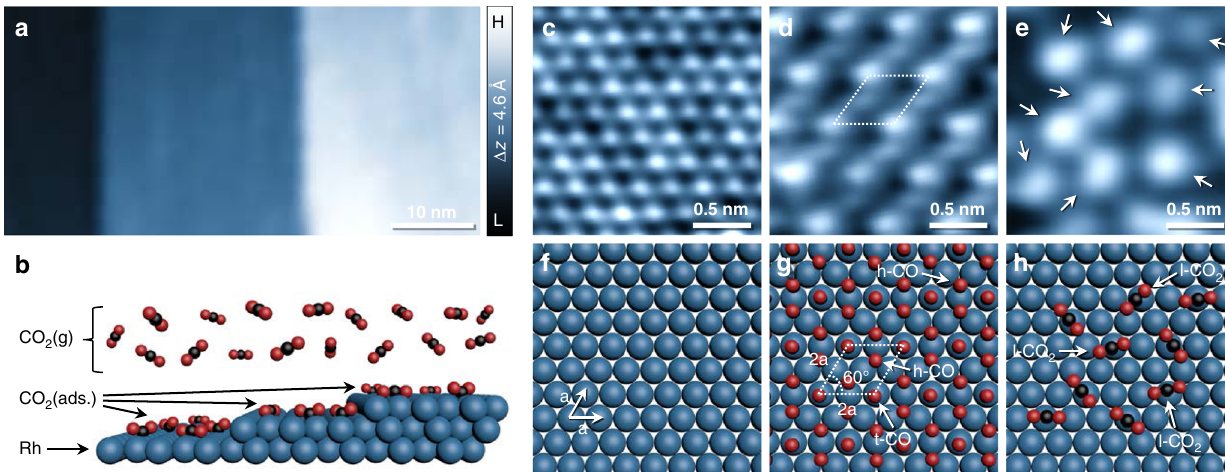
Fig. 1 Molecular adsorption structure of CO and CO 2 on the Rh(111) surface. a Freshly prepared wide-range STM image in UHV after cleaning cycles ( V t = 1.25 V; I = 0.17 nA). b Schematic illustration of the gaseous CO − e Representative atomic-resolution NAP-STM images t 2 /Rh(111) interface (side view). c of clean in UHV ( V t = 0.23 V; I t = 0.25 nA) ( c ), 0.75 ML of (2 × 2)-3CO chemisorption structure at 0.1 mbar CO ( V t = 1.03 V; I t = 0.16 nA) ( d ) and CO 2 physisorption structure at 0.1 mbar CO 2 ( V t = 0.54 V; I t = 0.16 nA) ( e ) on the Rh(111) surfaces. f − h Corresponding atomistic ball model illustrations of the observed NAP-STM images. Dark blue, black and red balls represent Rh, C and O atoms,